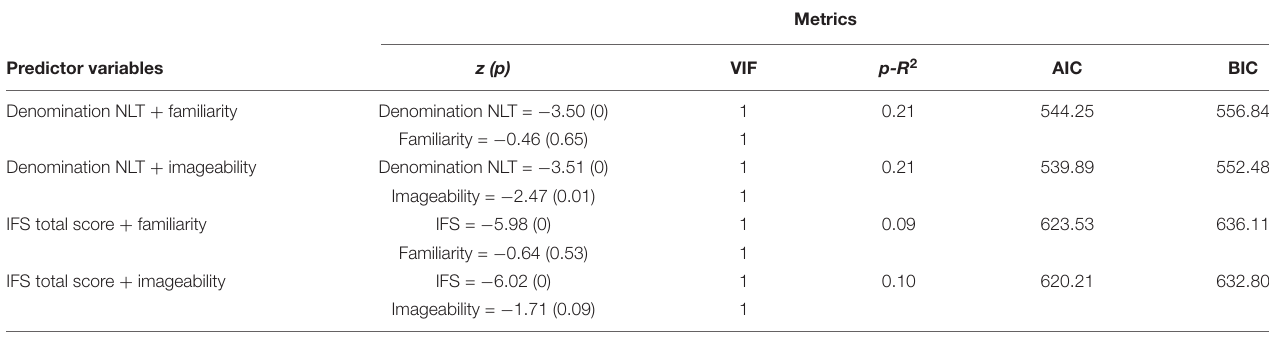
TABLE 2 | Logistic regression models combining the four variables suggested by the classification